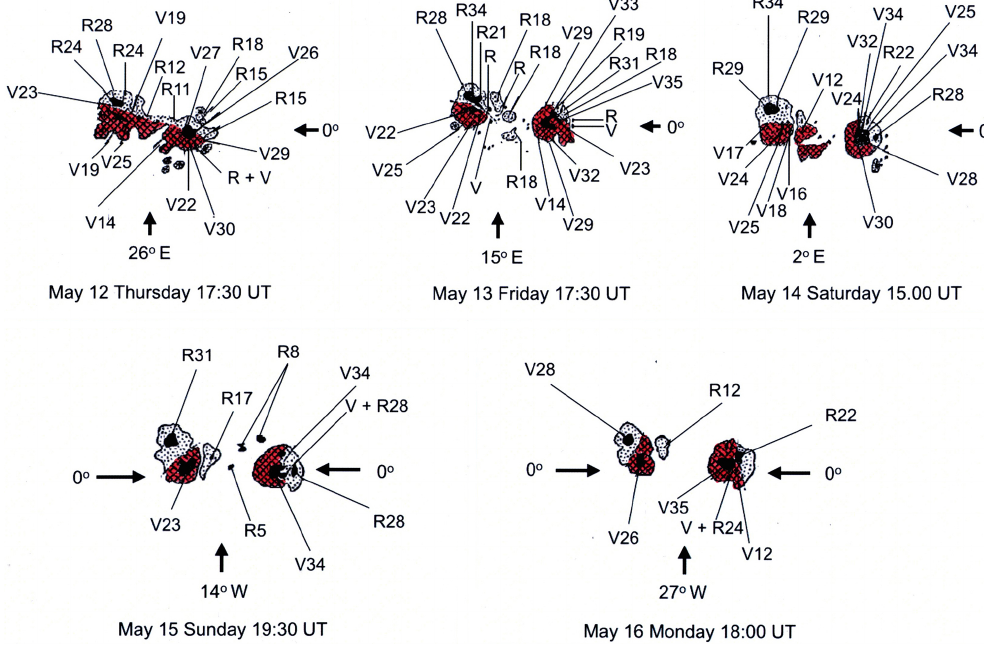
Figure 2. Active region 1842 observed at the Mount Wilson Observatory between 12 and 16 May 1921. V stands for negative magnetic field and R for positive. V25 e.g. corresponds to − 0 . 25T or corrected − 0 . 24T (Livingston et al., 2006). Large hatched areas of negative polarity are coloured red. When the large region after 12 May is broken up into two regions, the left starts to rotate counter-clockwise and the right clockwise. New negative flux is also seen to emerge on 14 May.